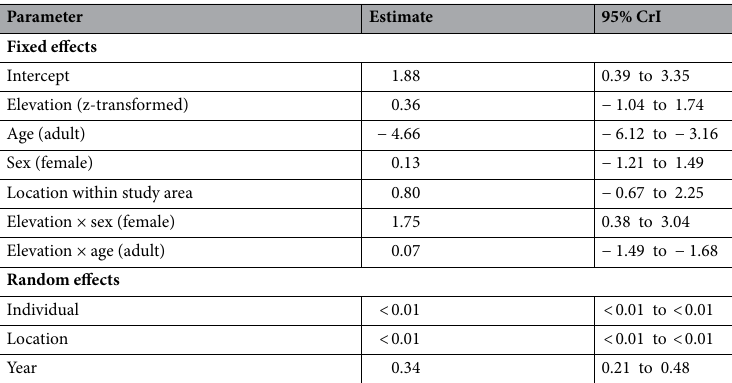
Table 2. Parameter estimates of the binomial mixed model investigating factors affecting dispersal probability. The estimates are given as obtained from the Laplace approximation. The lower and upper limits of the 95% credible intervals are based on Monte Carlo simulation of the posterior distribution. For the random effects the among-group standard deviation is given. N = 126 recaptures of 89